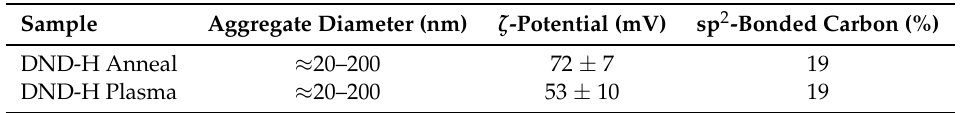
Table 1. Summary of material properties of the hydrogenated DND particles, including ζ -potential, aggregate diameter, and sp 2 content determined using